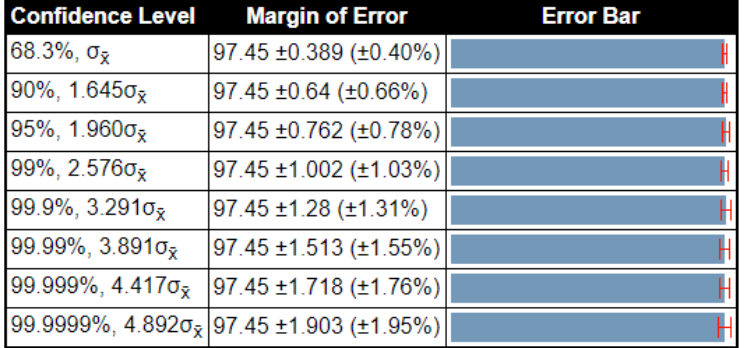
Figure 10. Confidence-interval-based analysis of the proposed method results.